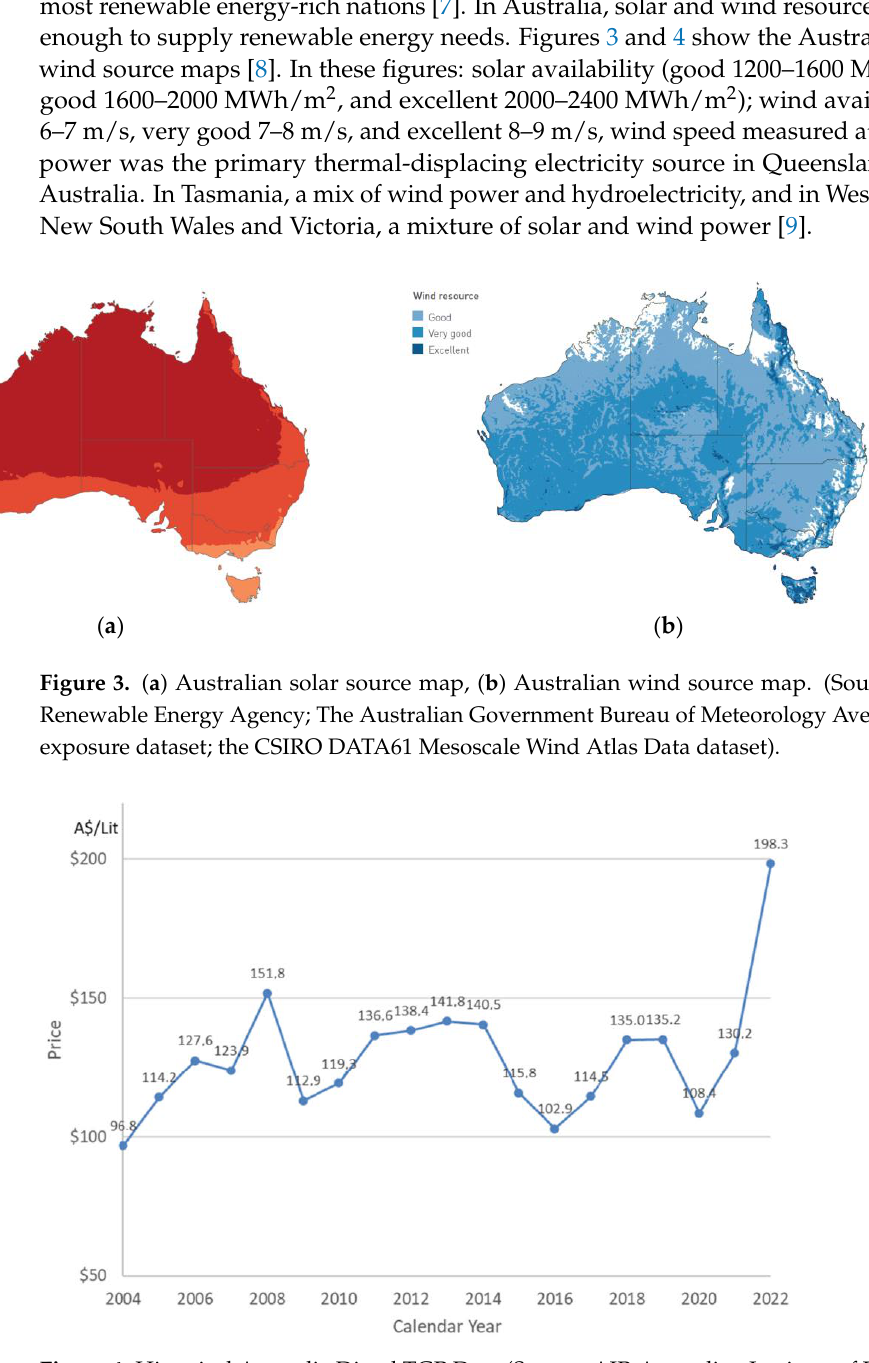
Figure 4. Historical Australia Diesel TGP Data (Source: AIP-Australian Institute of Petroleum).